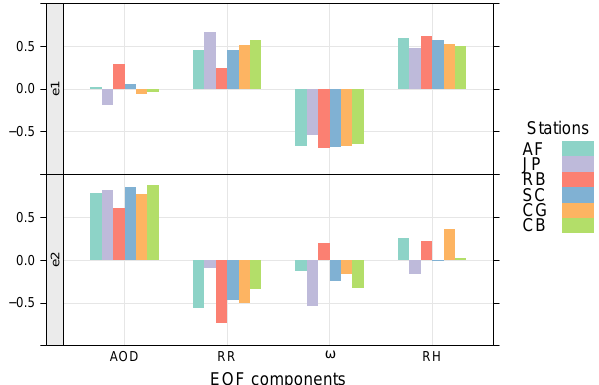
Fig. 10. EOFs and their AOD, RR, ω , and RH components for each AERONET station for all selected cases (see Sect. 2.4) during the months of September, October, November and December of 1999– 2012. Colors indicate the stations of Alta Floresta (AF), Ji Paraná (JP), Rio Branco (RB), Santa Cruz (SC), Campo Grande (CG), and Cuiabá